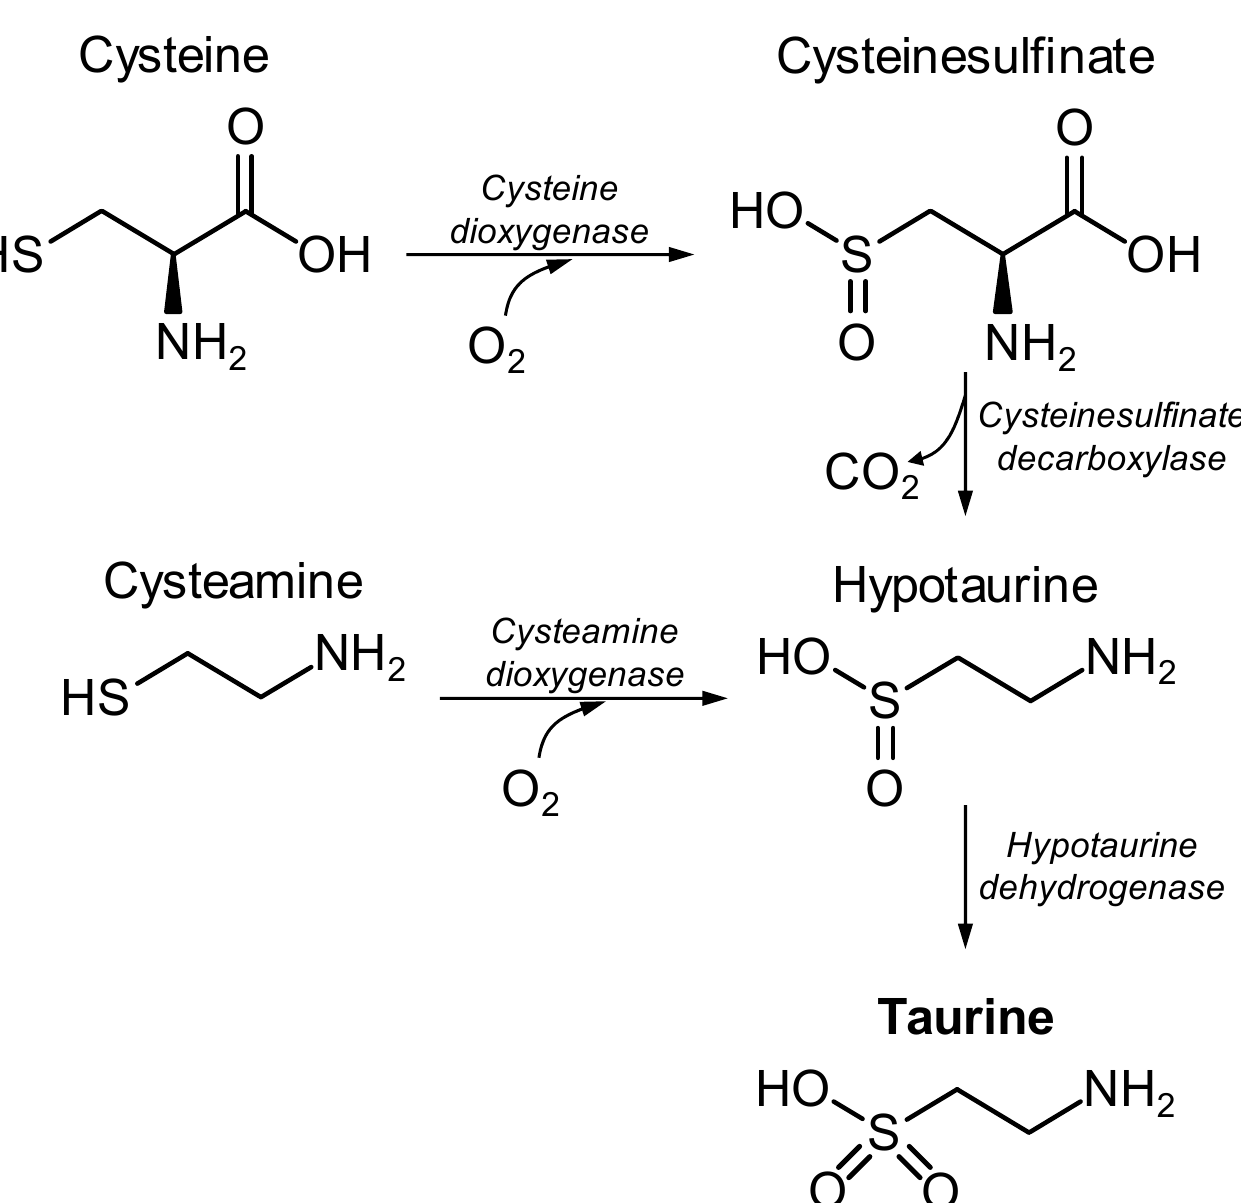
Figure 1. Synthesis of taurine in mammals from the sulfur amino acid cysteine. Taurine is one of the most abundant metabolites in the central nervous system (CNS), whose levels show substantial variations across species, brain areas, and developmental stages (Figure 2). The particularly high concentration of taurine in the developing brain further suggests its developmental importance. Indeed, a relation between plasma taurine and neurodevelopment has been proposed [16]. This role of taurine in CNS development was made clear by experiments on cats fed a taurine-deficient diet [17]. More recent research proposes that taurine has neurotrophic effects, playing an important role in neurite outgrowth, synaptogenesis, and synaptic transmission during the early stages of brain development [18,19].